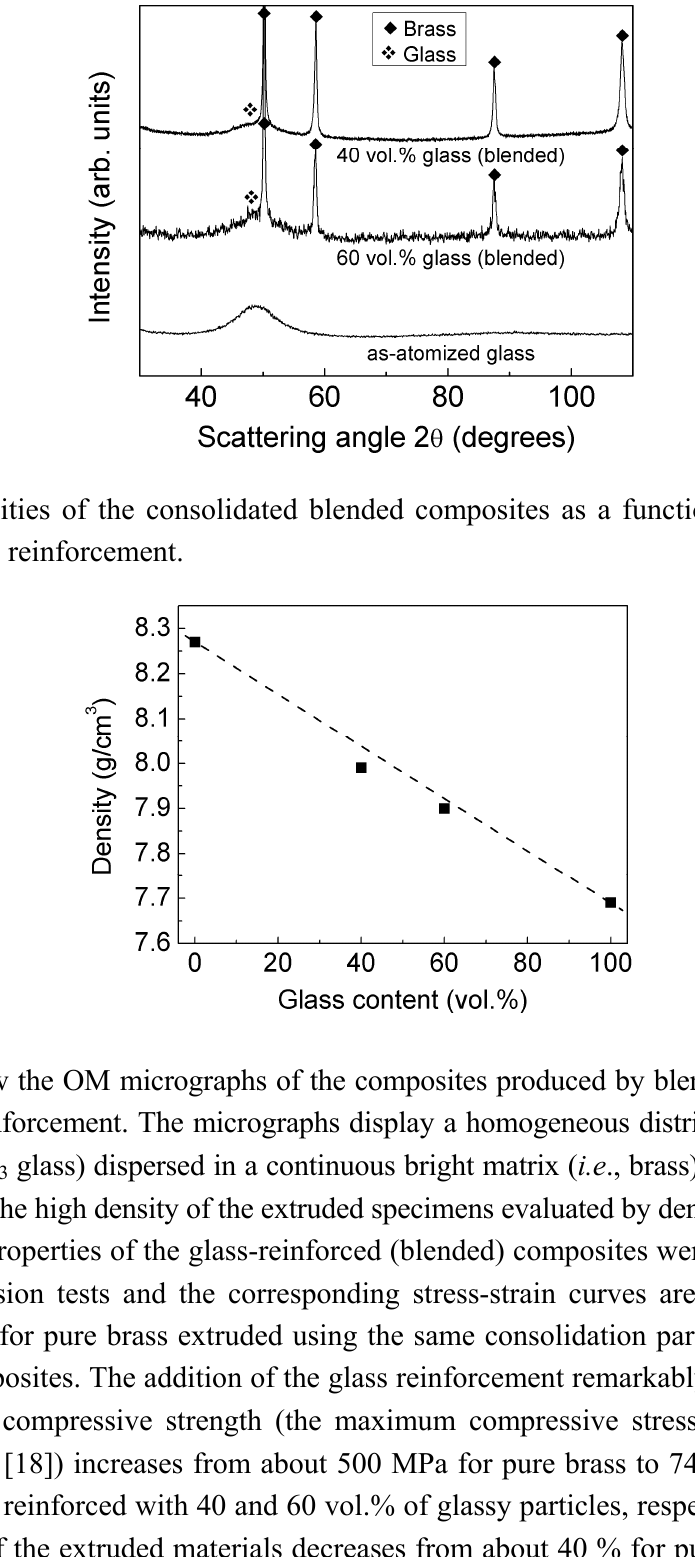
Zr Ti Si Sn powder 59 20 16 2 3